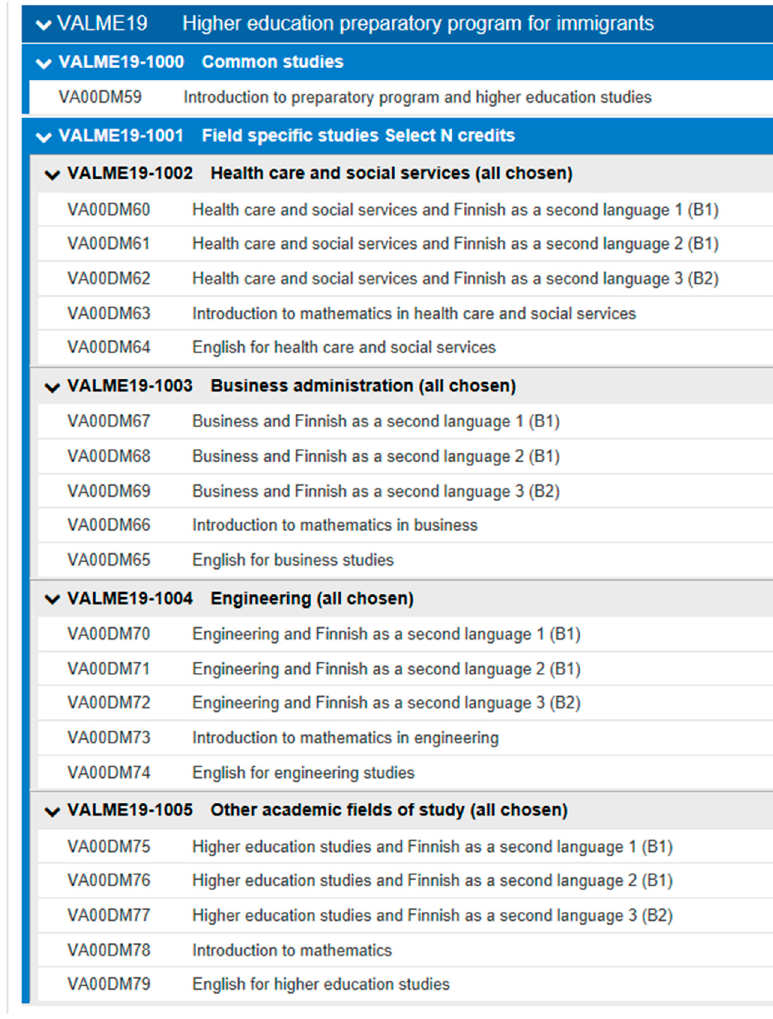
Figure 3. The study plan for the higher education preparatory program for immigrants (Xamk 2018).